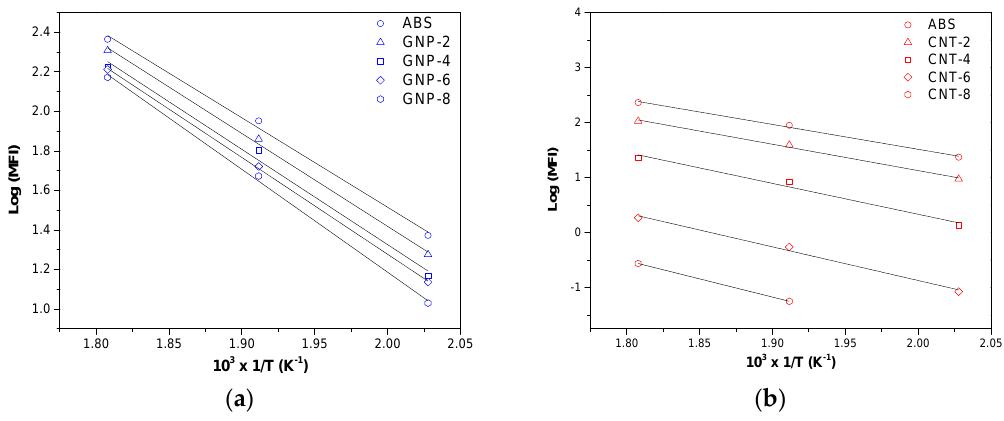
Figure 4. Melt flow index as a function of temperature of the composites with ( a ) graphene and ( b ) carbon nanotubes.